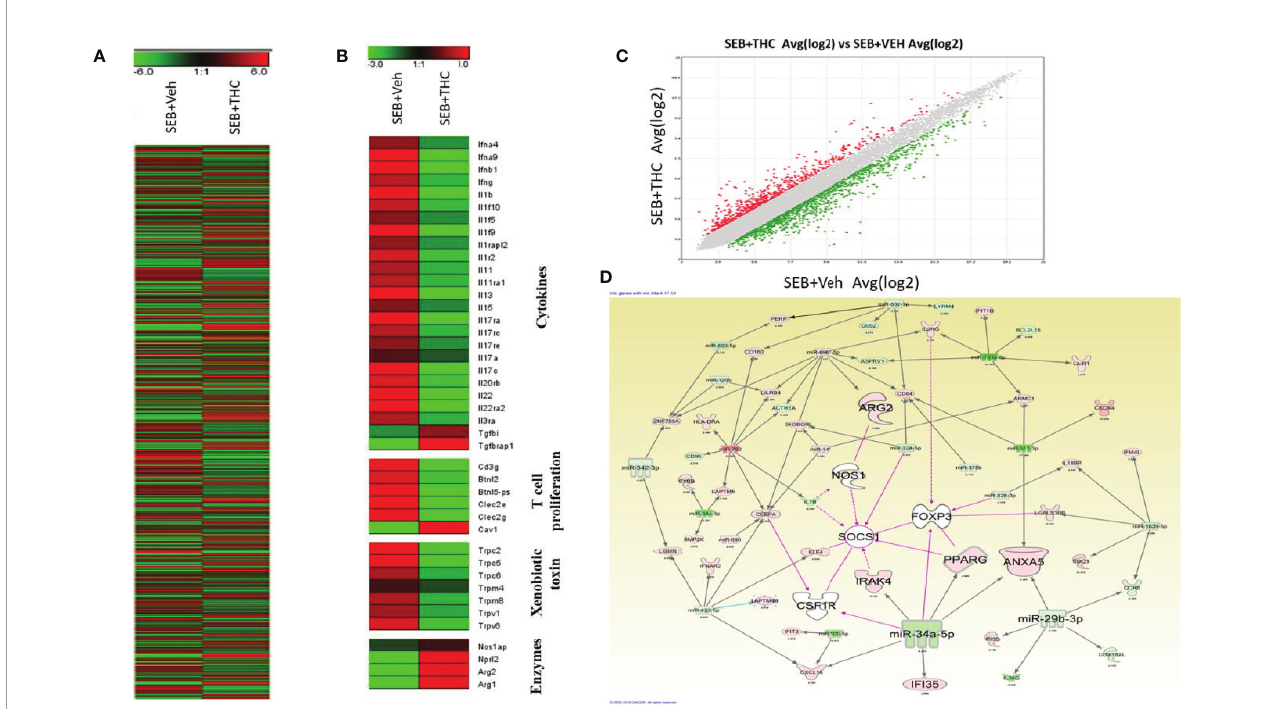
FIGURE 5 | THC treatment affects transcriptional pro fi les of gene expression in lung in fi ltrated MNCs of mice exposed to SEB. Groups of fi ve mice were treated with SEB + Veh or SEB + THC as described in Figure 1 legend. MNCs from the lungs were isolated and subjected to transcriptional analysis as described in Methods. (A) Heat map of all genes in SEB + Veh and SEB + THC groups. (B) Heat map showing speci fi c genes associated with cytokines, T cells proliferation, xenobiotic toxin, and in enzymes in SEB + Veh vs. SEB + THC groups. (C) Scatter plot up- and downregulated genes post calculation of total genes (linear). (D) Shows relationship between genes and miRs post IPA analysis of dysregulated genes detecting the genes regulating Tregs and MDSCs to